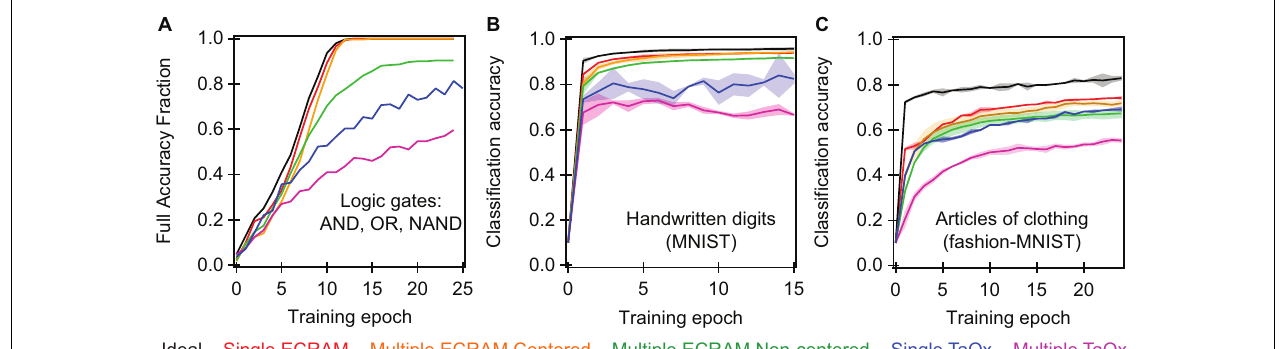
FIGURE 6 | Simulated accuracy of (A) logic gates, (B) handwritten digits classification, and (C) articles of clothing classification. (A) used a single-layer 3 × 3 perceptron network like experiment; the full accuracy fraction denotes the fraction of seed values that are able to achieve 100% accuracy for all twelve permutations of for the three logic gates designed by Figure 2A . Two multi-layer perceptron networks, each with a single hidden layer, were simulated in (B) and (C) . The accuracy denotes the fraction of the data that was correctly classified. The handwritten digits classification (B) used a 65 × 36 and a 37 × 10 crossbar, while the articles of clothing classification (C) used a 785 × 400 and a 401 × 10 crossbar. The single ECRAM and single TaOx memristor cases use the switching properties from a single device and assumes all devices are identical in the array. The multiple ECRAM and multiple TaOx cases account for device-to-device variation using interpolation between multiple device probabilistic maps (look-up-tables), as described in Agarwal et al. (2016) and Bennett et al. (2019a). Centered simulations correct for differences in the equilibrium conductance of the device, so they are all oriented around a single conductance value (as was done experimentally with bias devices) while the non-centered simulation does not perform this correction. All simulations show significant improvement of ECRAM over TaOx, as well as the importance of accounting for device-to-device variations. The shaded regions represent two standard deviations of the simulation, each conducted over 100 random “seed” initial